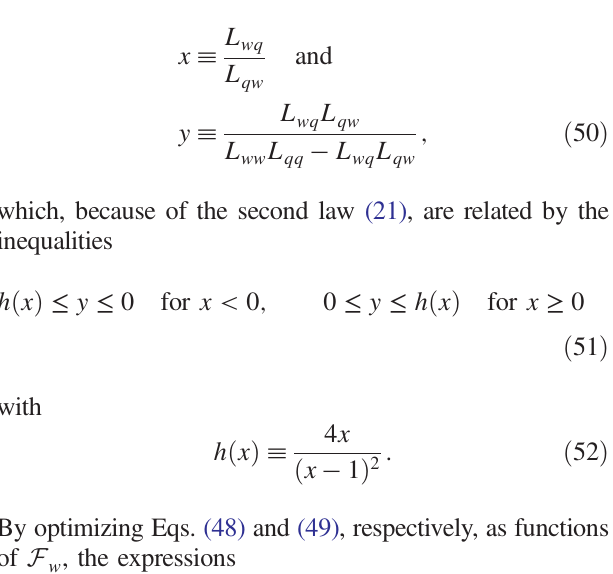
ffiffiffiffiffiffiffiffiffiffiffi p y þ 1